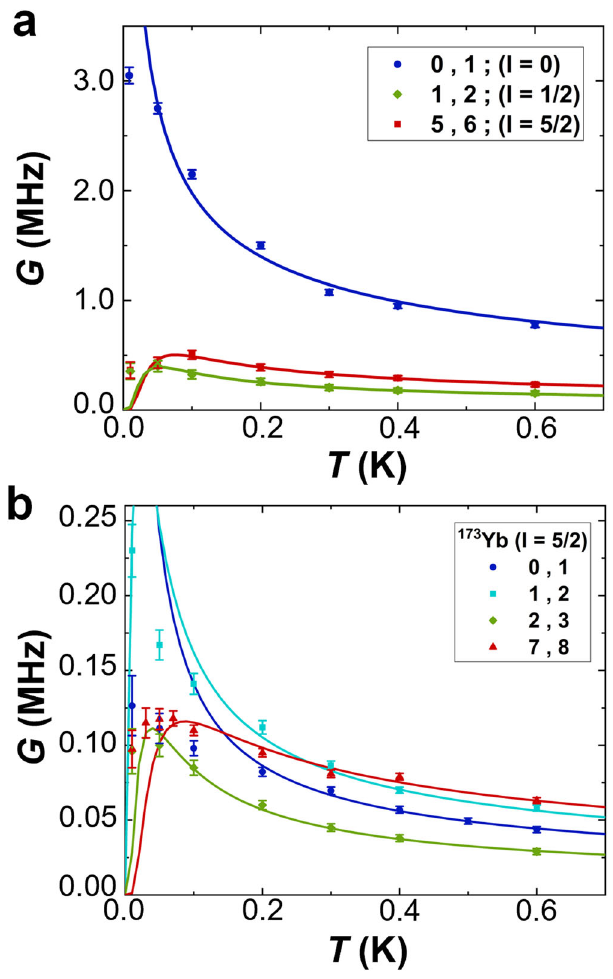
hyper fi ne coupling while the last term accounts for the quadrupolar interaction of the nuclear spin. Parameters for the three different Yb isotopes are summarized in